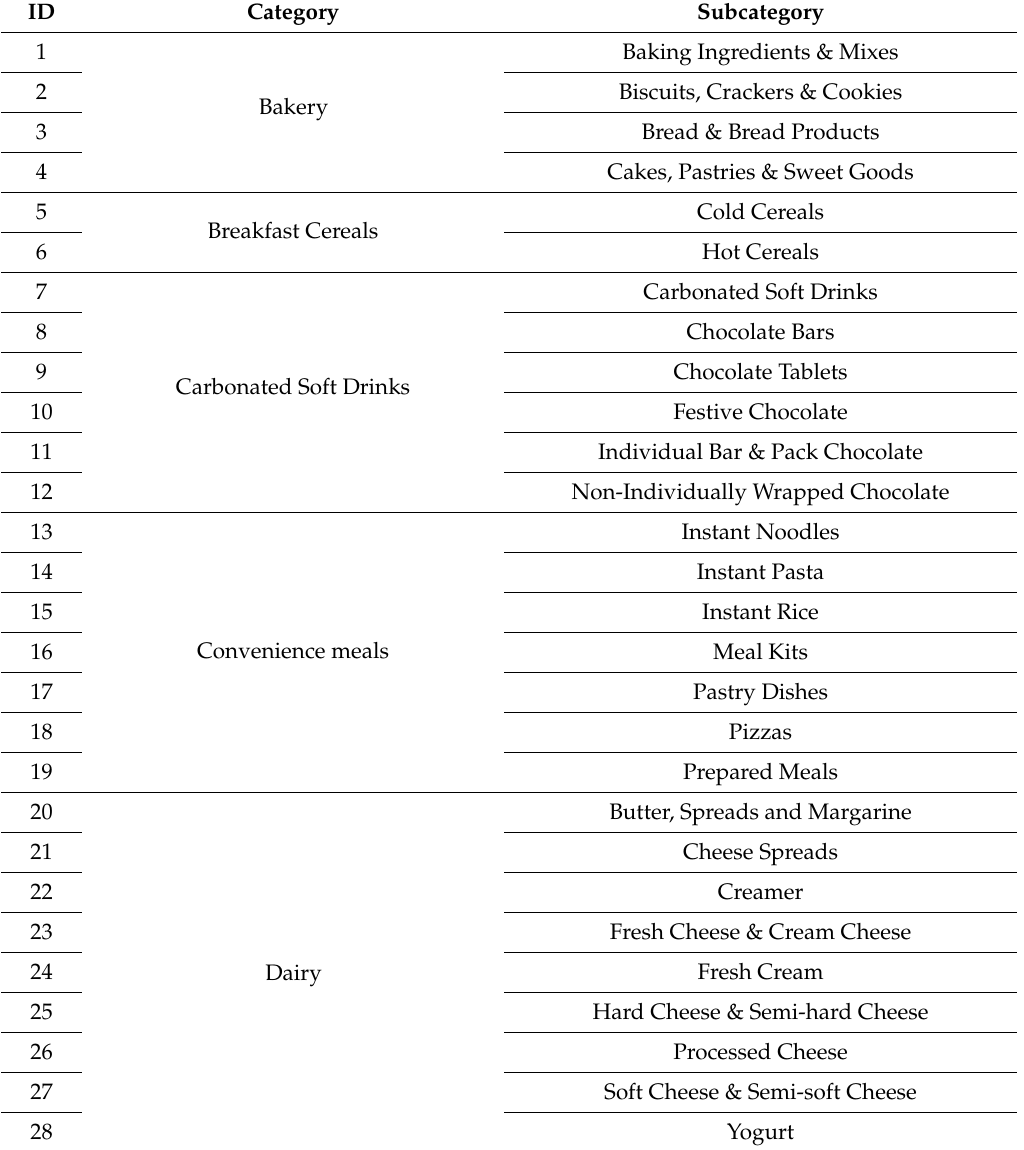
Table A1. The list of categories and subcategories on